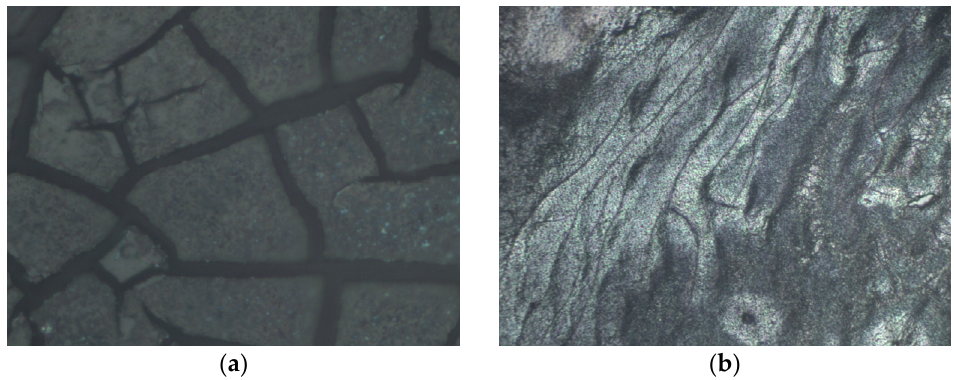
Figure 1. Optical images of ( a ) a CZTS NCs film, and ( b ) CZTS NCs with 10% of PEDOT:PSS added.